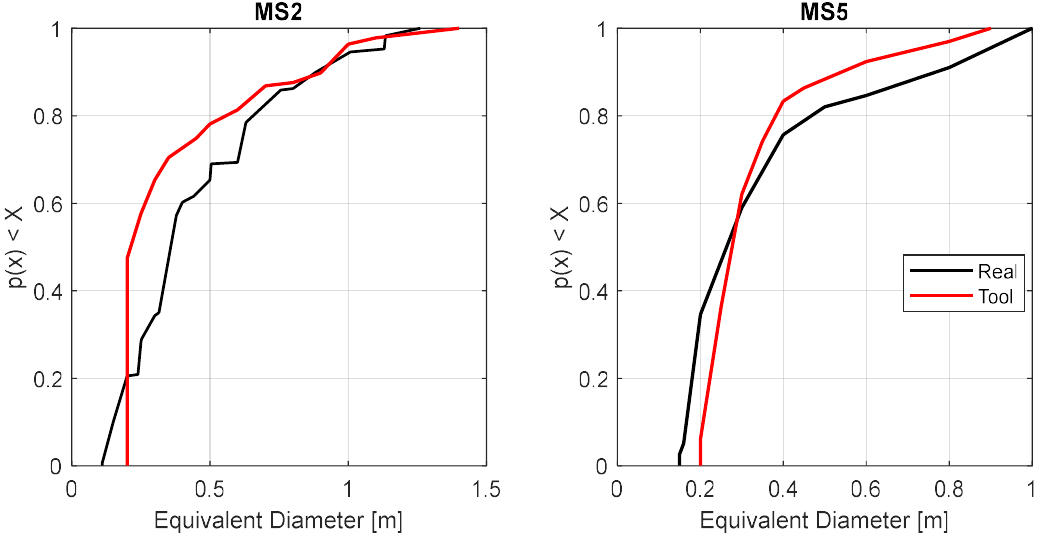
Figure 3. Empirical cumulative distribution functions (ECDFs) of pipes maximum cross section height for the generated and real drainage network. Results for MS2 are on the ( left ) and results for MS5 are on the ( right ).